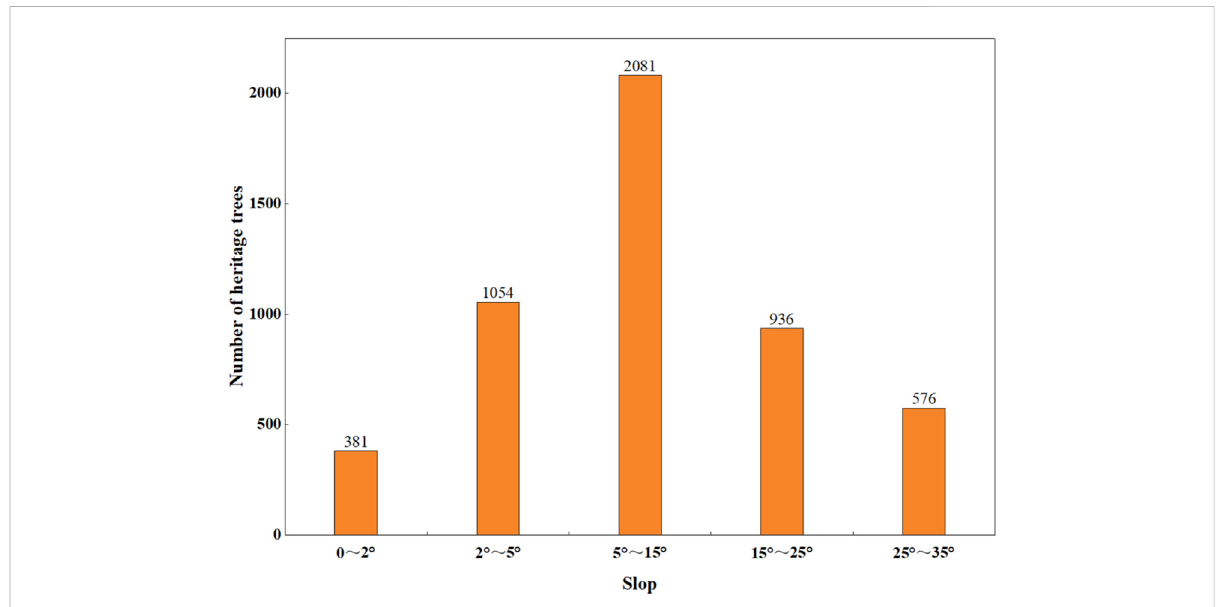
FIGURE 6 Number of heritage trees under different slopes.